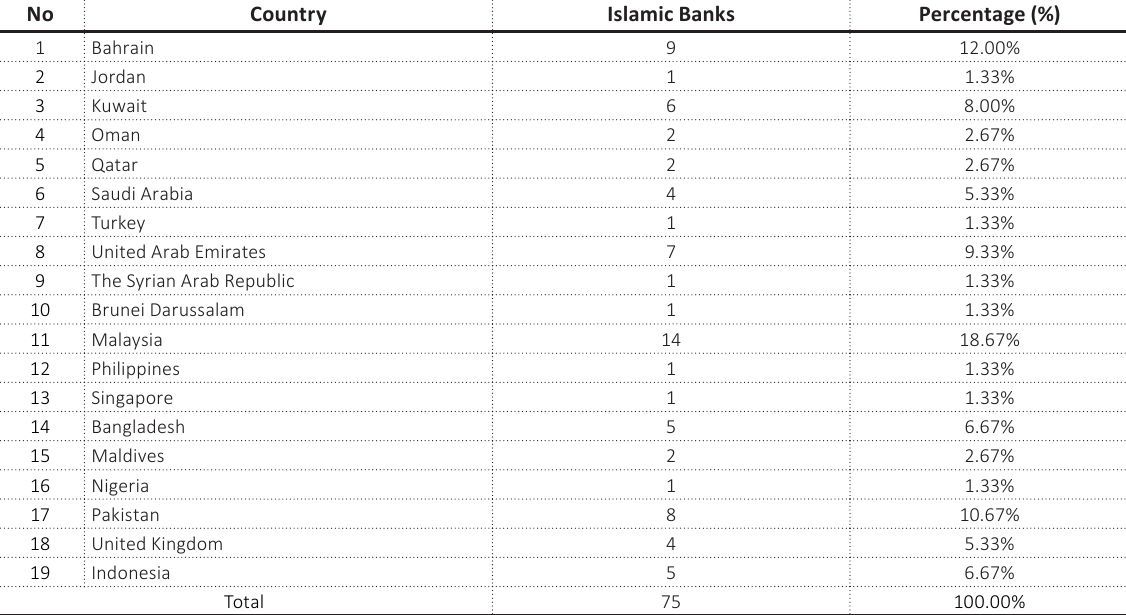
Table 1. Distribution of